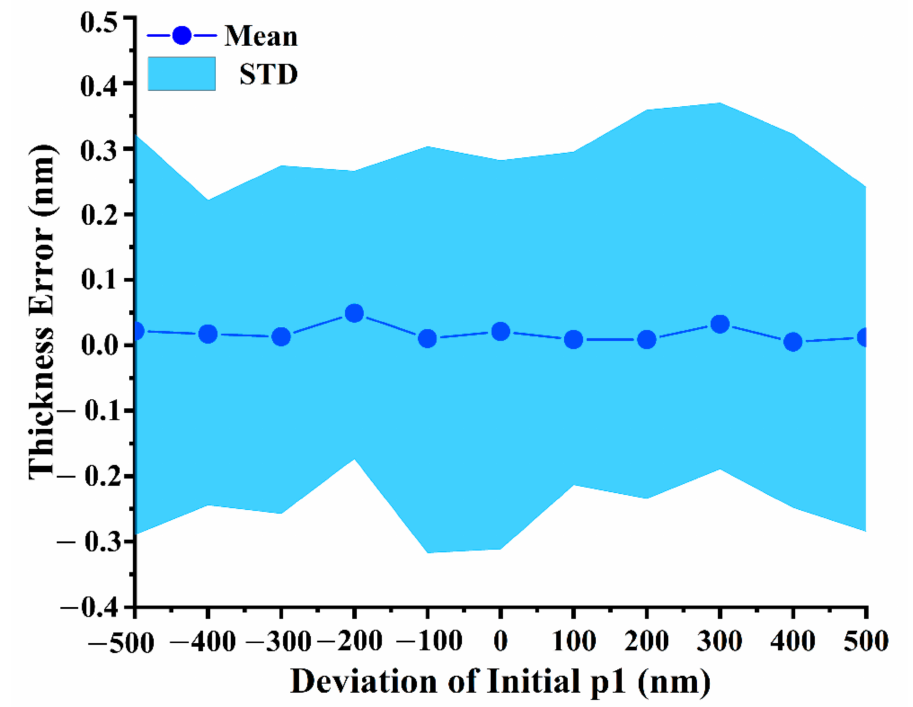
Figure 6. The influence of the initial peak